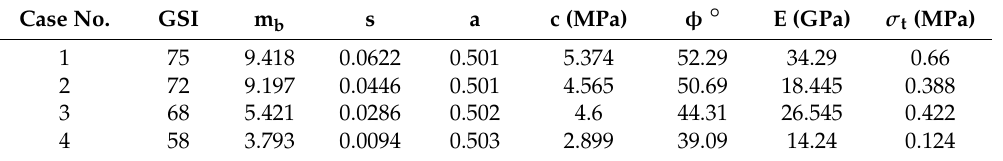
Table 11. Rock mass properties for different rocks units of the four projects. Case No. GSI